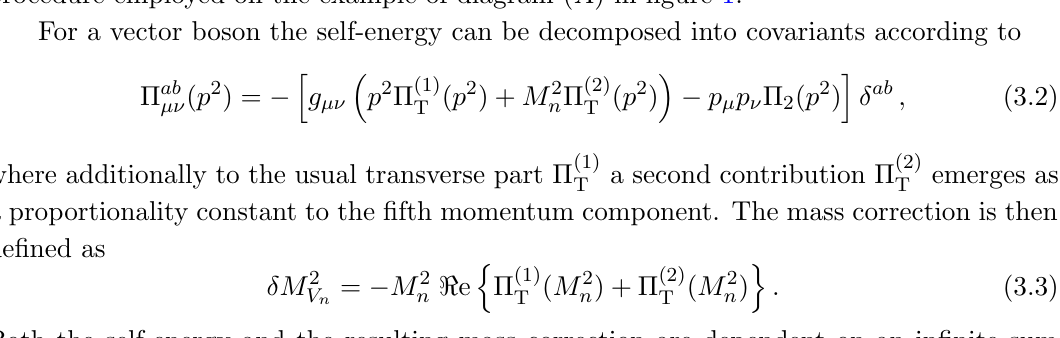
JHEP03(2018)093